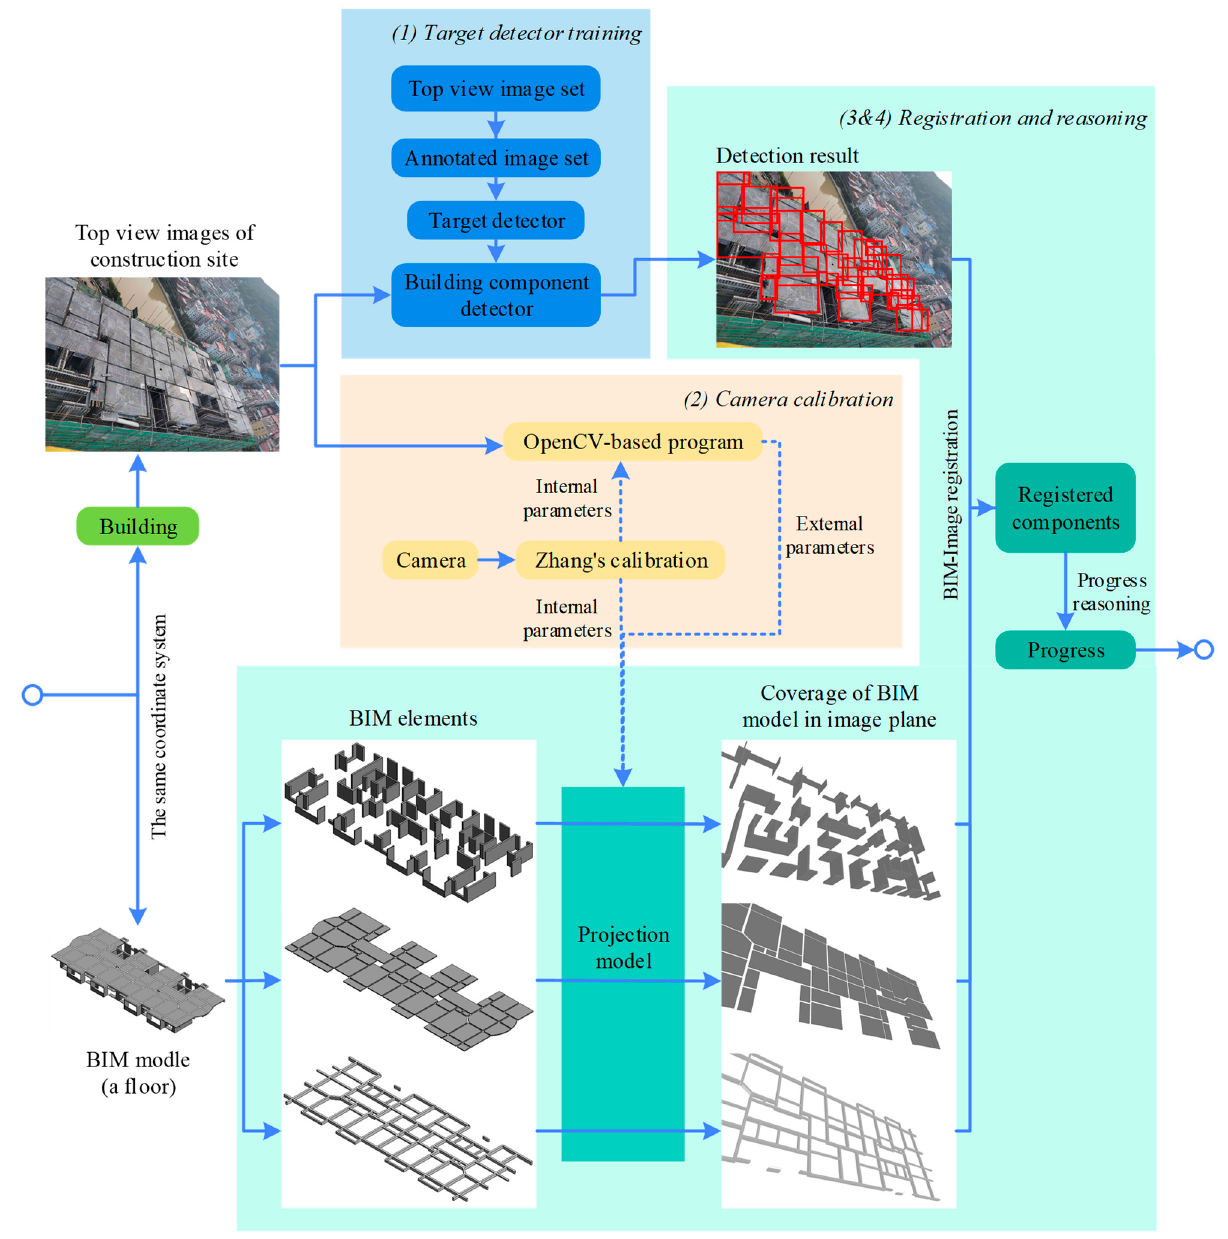
Figure 2. Overview of the method.